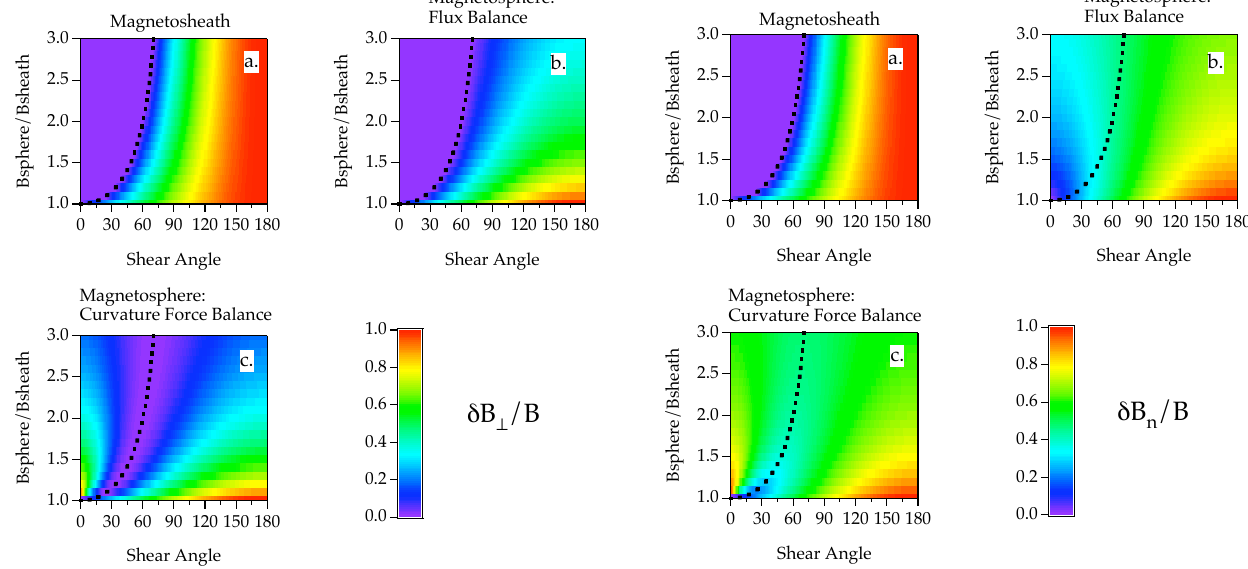
Fig. 2. Ratios of perturbations in the magnetic field component perpendicular to the event axis in the plane of the magnetopause to ambient magnetic field strengths as a function of the ratio of magnetospheric to magnetosheath magnetic field strengths and the shear angle between the magnetospheric and magnetosheath mag- netic fields: (a) in the magnetosheath for an event with a circular magnetosheath cross-section ( b 2 = a ), (b) in the magnetosphere for an event with a magnetospheric cross-section determined by flux balance, and (c) in the magnetosphere for an event with a mag- netospheric cross-section determined by force balance across the magnetopause. According to the component reconnection model of Sonnerup (1974) and Gonzales and Mozer (1974), no reconnec- tion or FTEs can occur in the region of parameter space above the dashed lines in each panel.